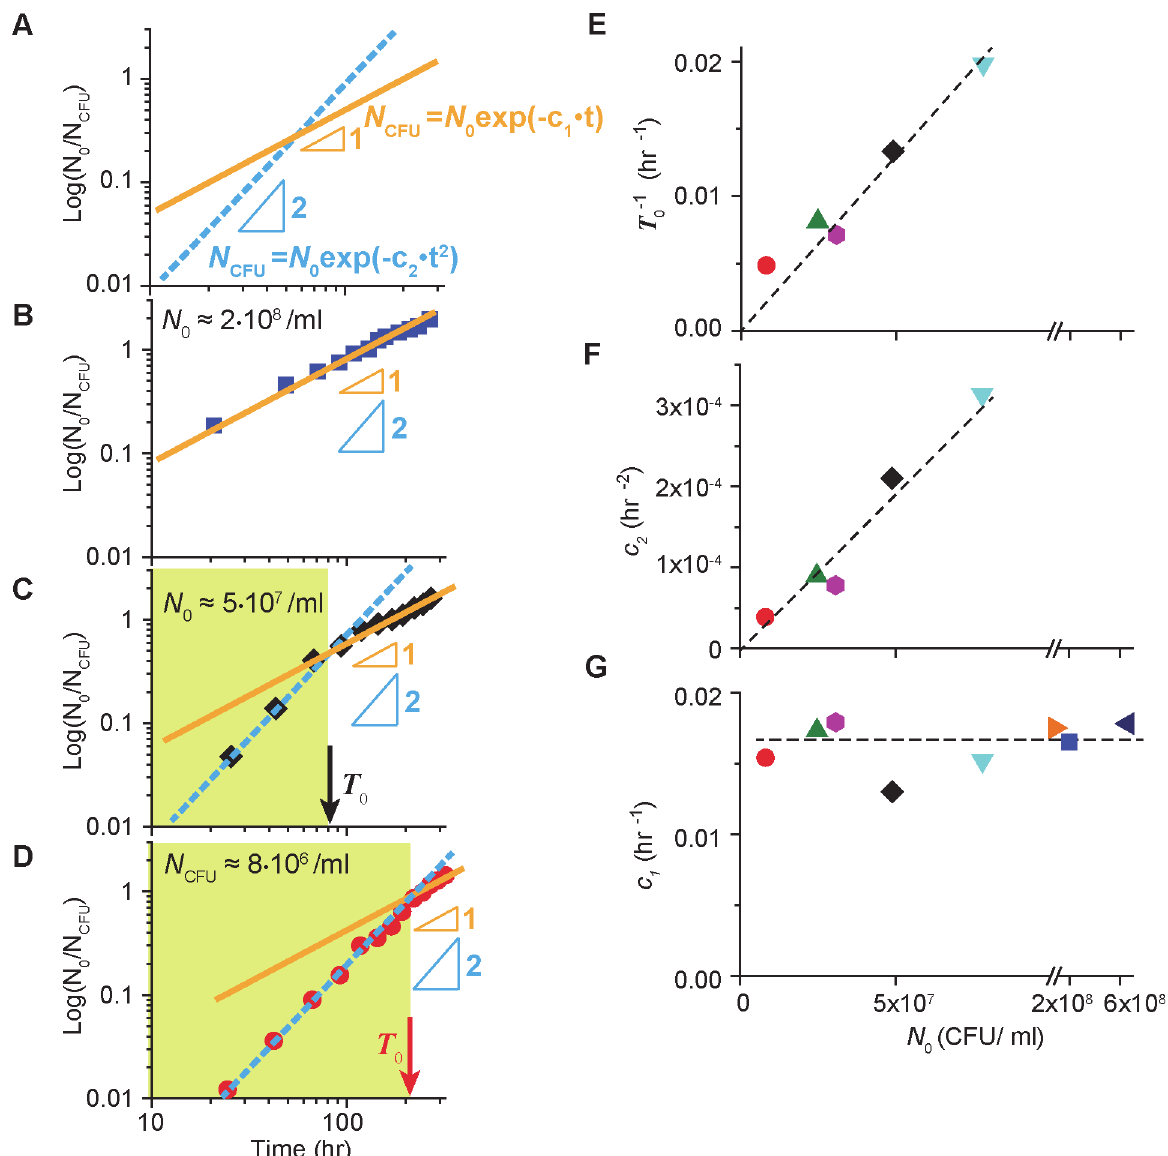
Fig 3. Quantitative analyses of the survival kinetics of wild type cells. (A) The log-log plot of log ( N 0 /N CFU ), where N 0 is the number of CFU at the time zero, reveals the power law exponent of exponential functions; see the text, and Eqs (1) and (2). (B) At high cell density, N CFU of the wild type cells plotted as described above follows a straight line with a slope of 1, indicating that the survival kinetics can be described by Eq. (1); see also S7A Fig for another high cell density. (C-D) At lower cell density (see also S7C Fig — S7E Fig for other low cell densities), the slope is initially 2 (green region), but becomes 1 later, revealing the biphasic decay seen in Fig. 1. The time at which the transition occurs is marked as T 0 (arrows). Numerically, T 0 is obtained from the time point at which the orange line and the cyan dashed line intersect. Note that T 0 is greater for lower density. (E) T 0 − 1 is linearly proportional to N 0 . (F, G) We obtained the coefficients c 1 and c 2 in Eqs (1) and (2) by fitting the second phase and the first phase of the biphasic decay respectively. Note that for high cell densities which show a single-phase decay, we used Eq. (1) to fit the entire range, and c 2 is not available. We see that c 2 increases linearly to N 0 ( c 2 / N 0 ) in Fig. 3F. In Fig. 3G, we see c 1 remains constant for different N 0 . The dashed lines are plotted for a visual guide. To obtain coefficients in Eqs (1) and (2) for the low cell-density cultures, we fit the data in and in t (cid:5) T are fitted using Eqs (2) Fig. 1 and S2 Fig using the equations; the data in t < T 0 0 and (1) respectively. We see that c increases linearly to N in Fig. 3F. Hence, c = c (cid:3) N , where 2 0 2 0 (cid:1) μ remains constant for different N , and c in Fig. 3G. c is a constant. Also, we see that c 1 0 1 o